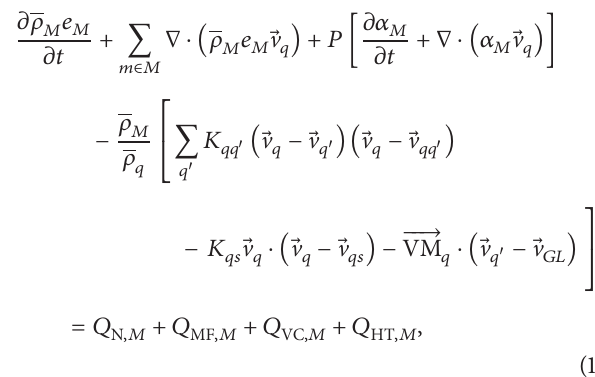
on the mass and energy distributions calculated by the other code elements [18,